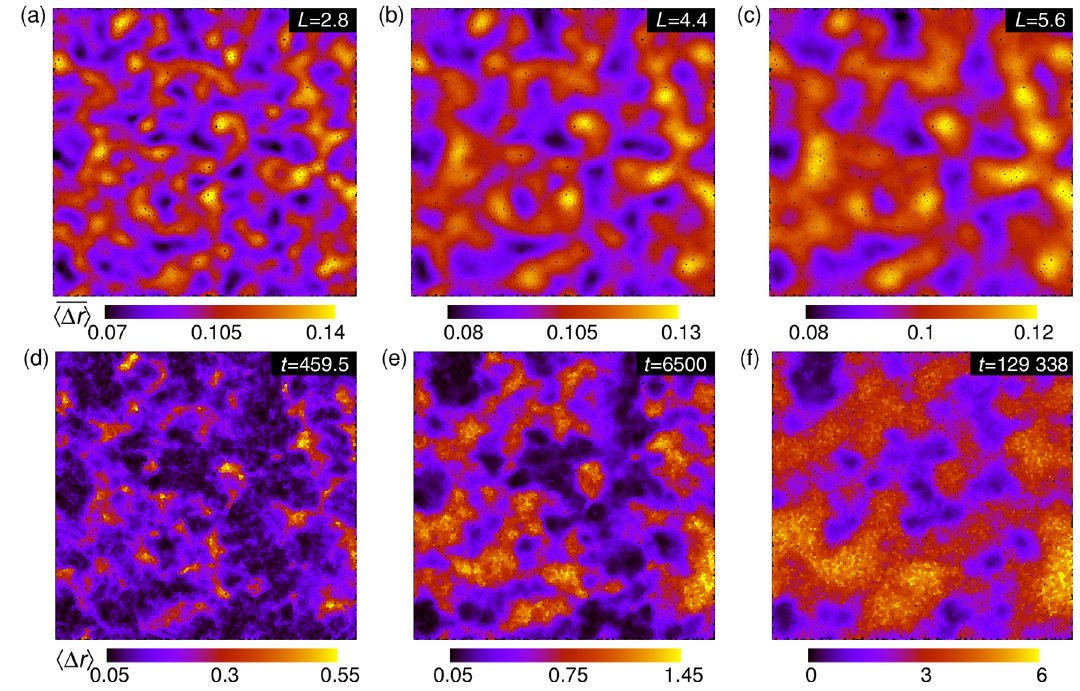
FIG. 7. Correlation of fast and slow dynamics. (a) – (c) Spatial distribution of dynamic propensity coarse grained from the one at β timescale t ¼ 10 . 7 for the 2D polydisperse system ( Δ ¼ 11% ) at T ¼ 2 × 10 − 3 [i.e., Fig. 2(a1) for fast dynamics]. (d) – (f) Spatial distribution of dynamic propensity corresponding to Figs. 2(a2) – 2(a4), but here the dynamics is stopped at t ¼ 10 . 7 and then restarted by assigning each particle a new velocity from the Maxwell-Boltzmann distribution at the same temperature. The new velocity field is different from and independent of the initial one, so the dynamic correlation before and after t ¼ 10 . 7 is totally eliminated after this operation. Note the clear resemblance between (a) – (c) [(d) – (f)] and Figs. 2(b2) – 2(b4) [Figs. 2(a2) – 2(a4)]. This indicates the common structural origin behind fast β and slow α